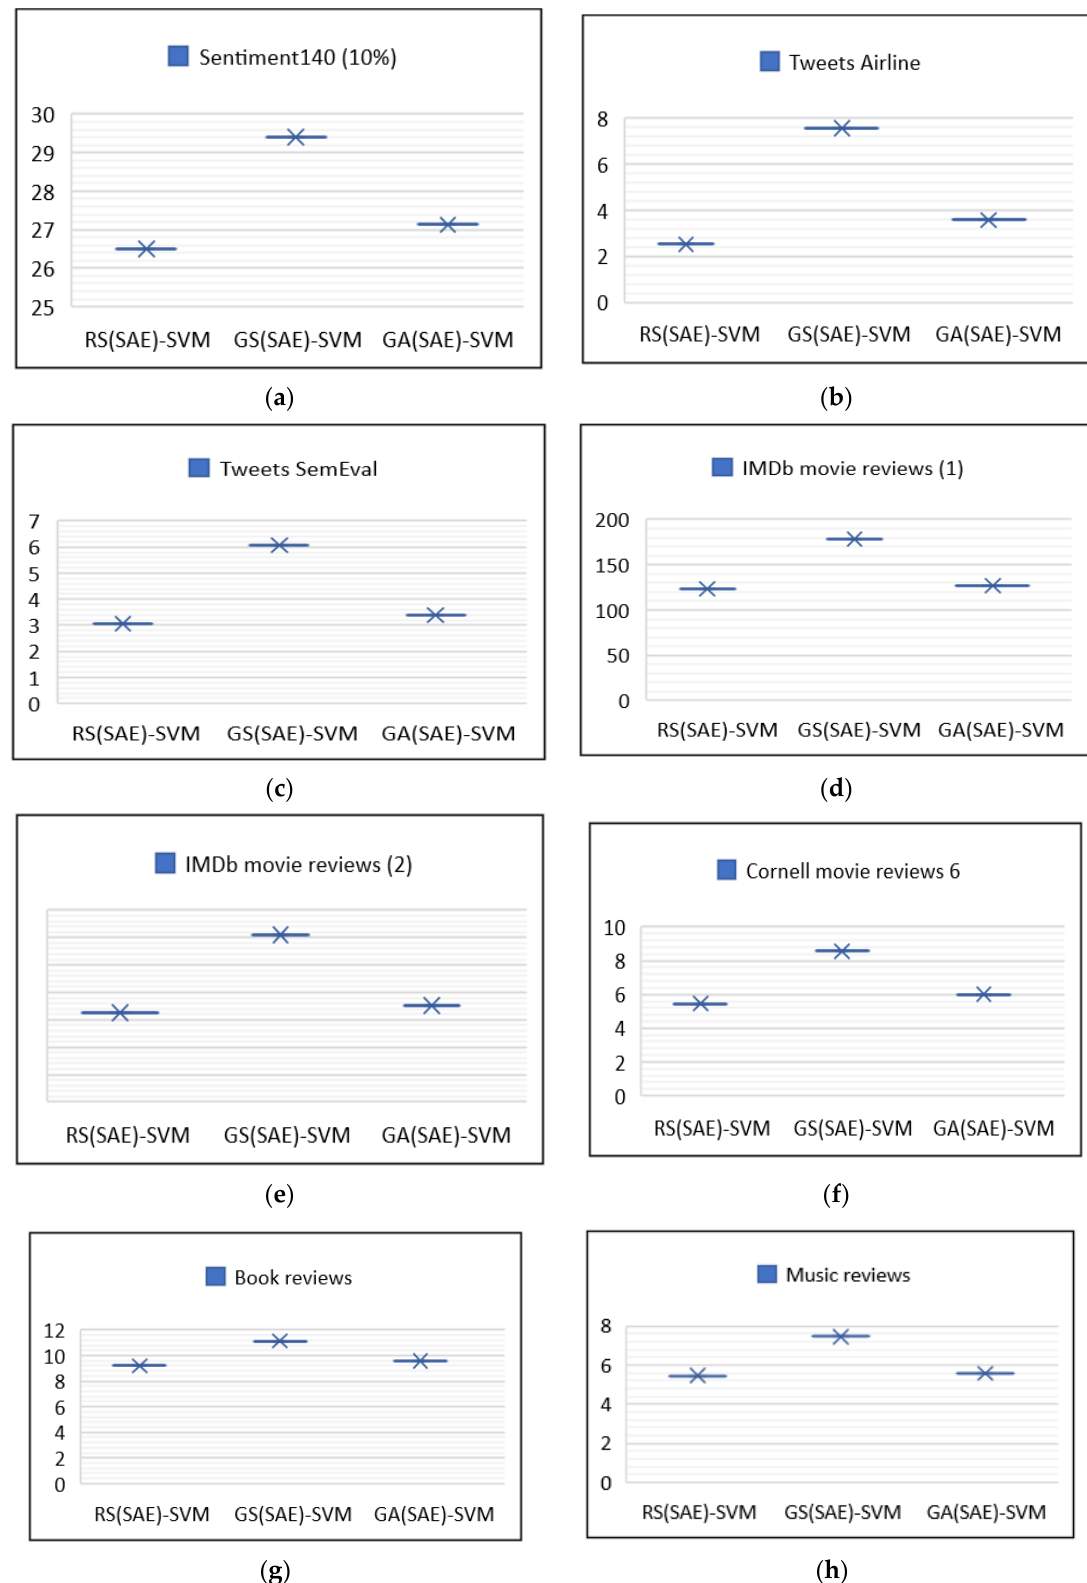
Figure 5. Processing times for experiments .